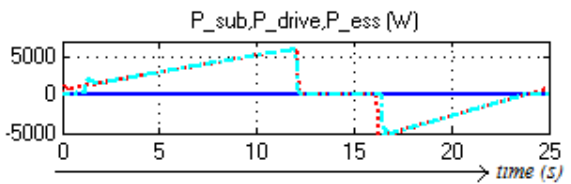
Fig. 20. Simulation diagram of power for both C = 31.5 F and C = 63 F in autonomous mode.